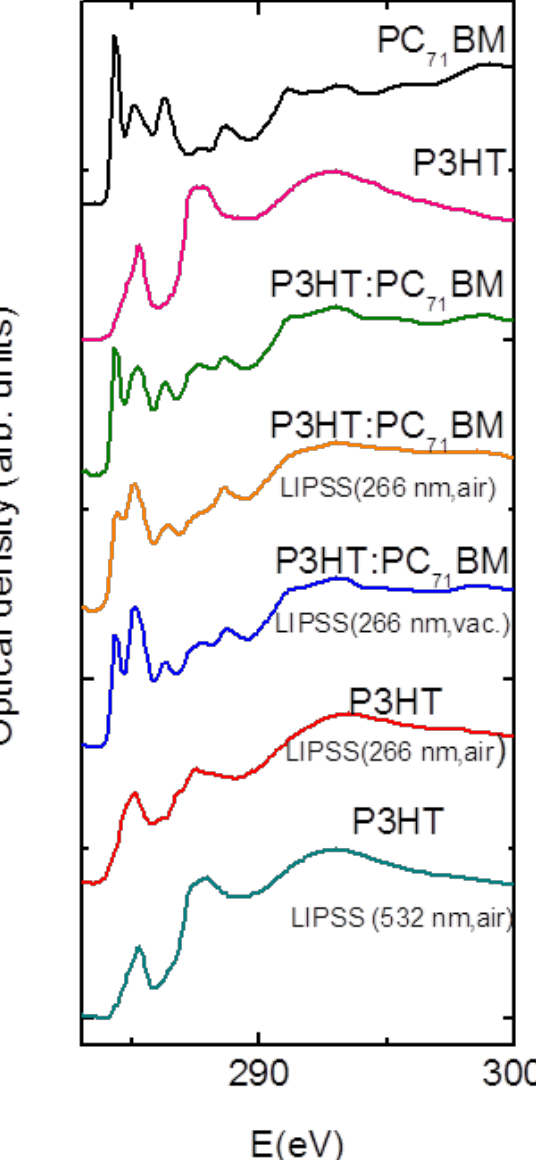
Figure 4. Transmission near-edge X-ray absorption fine structure (NEXAFS) spectra of P3HT:PC 71 BM (1:1) films: Spin-coated (green line), with LIPSS at 266 nm formed upon irradiation at ambient conditions (orange) and in a vacuum (blue). Spectra of P3HT and PC 71 BM thin films are shown as reference (magenta and black, respectively). For the sake of comparison, the spectrum of P3HT, irradiated at 266 and 532 nm in air, are also included (red and dark green lines, respectively). Aiming to diminish the effect of possible photo-oxidation at laser = 266 nm under ambient conditions, laser irradiation of P3HT:PC 71 BM thin films was carried under vacuum conditions (3 ×